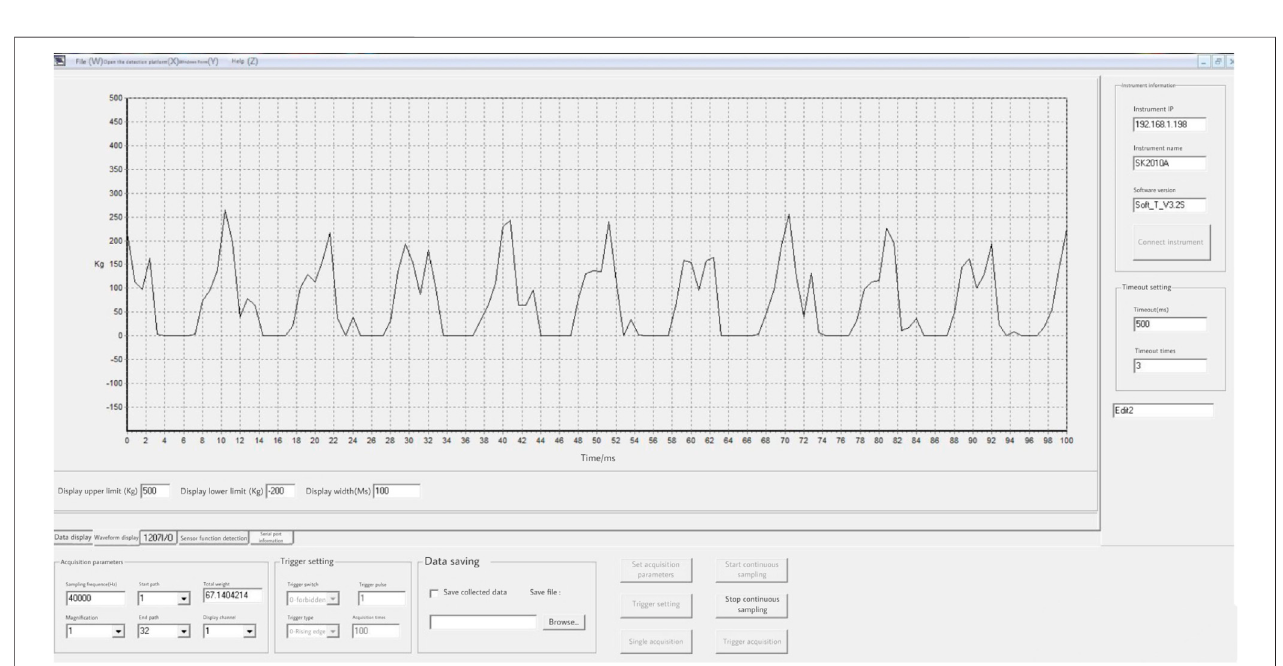
FIGURE 4 | Vibration signal